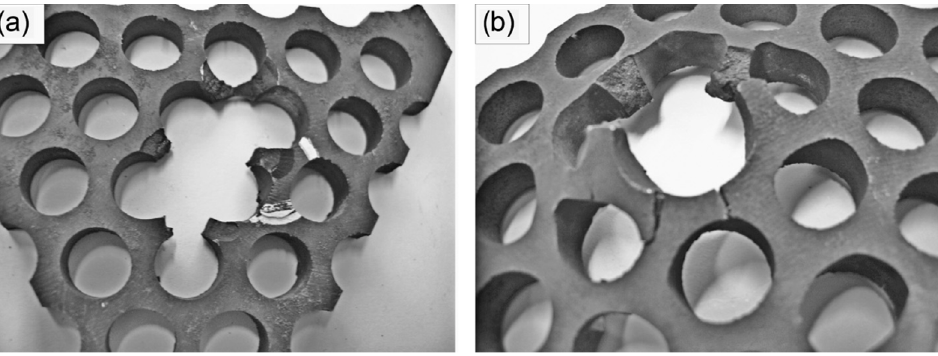
Figure 7. Damage on the back of the perforated plate: ( a ) ADI-275; ( b ) ADI-400 [37]. Reprinted with permission